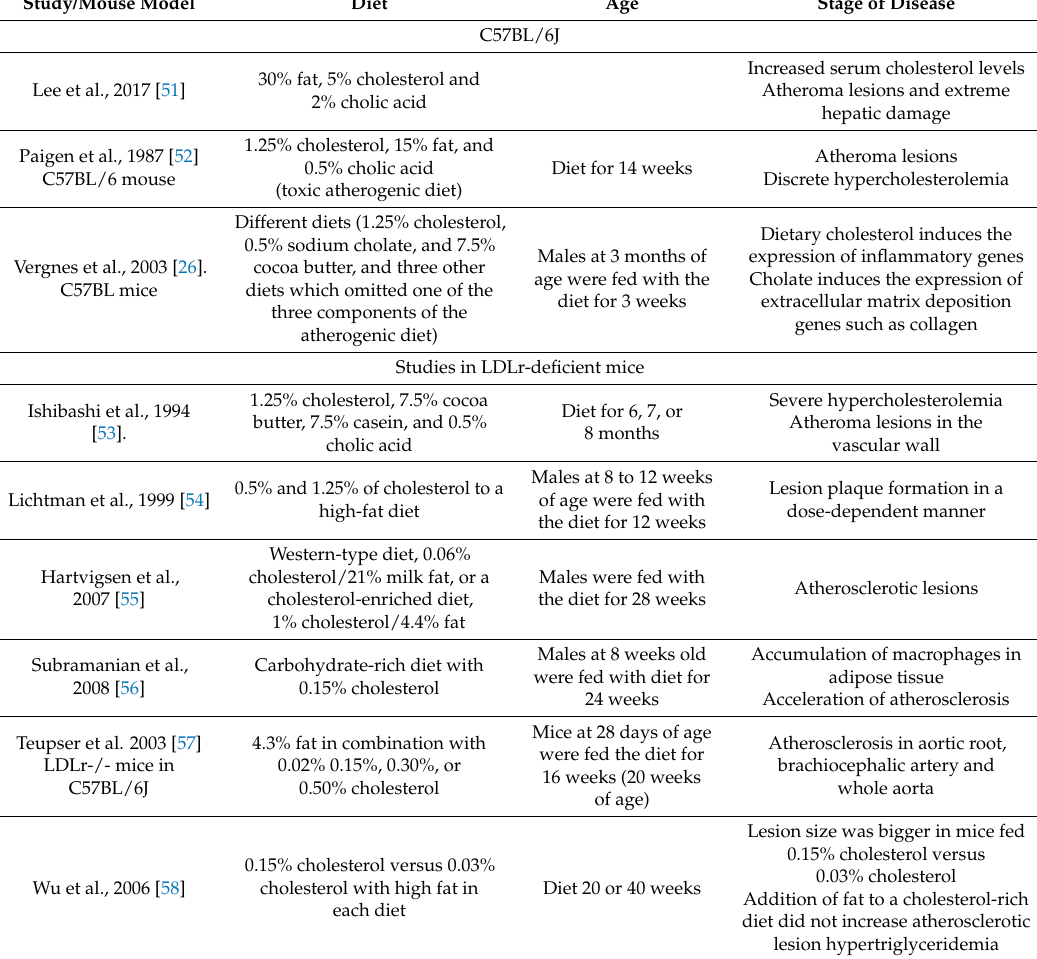
Table 3. Impact of dietary cholesterol in mouse models of